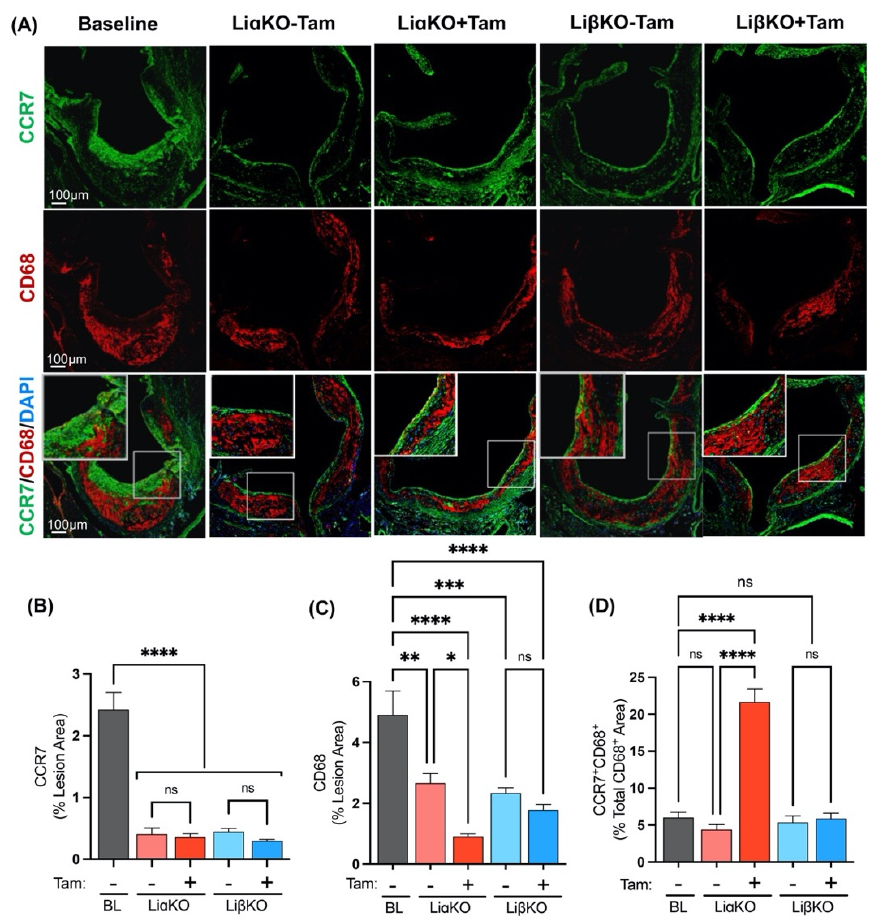
Figure 6. Female GSK3 α -deficient Ldlr − / − mice have elevated CCR7 expression. ( A ) Representative sections of aortic sinus immunostained with an antibody against CCR7 (green) and co-stained with CD68 (red). Quantification of ( B ) CCR7 and ( C ) CD68 area normalized to the total lesion area. ( D ) Quantification of co-stained (CCR7 and CD68, yellow) area normalized to the total CD68 (macrophage, red) stained area. n = 9–13; mean ± SEM; * p < 0.05, ** p < 0.01, *** p < 0.001, **** p < 0.0001 (one-way ANOVA). ns, not significant; Tam, tamoxifen; BL, baseline; CCR7, C-C chemokine receptor type 7.